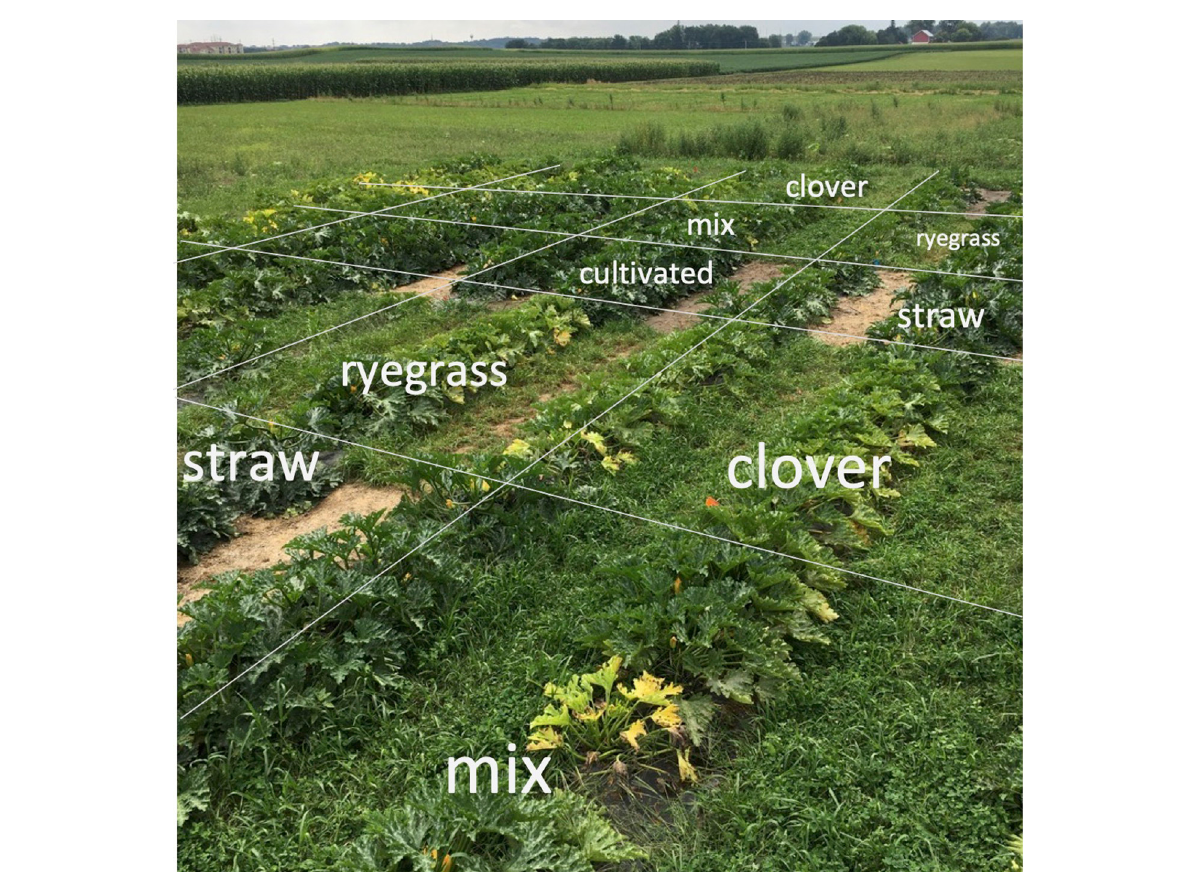
FIGURE8 Photograph of organic zucchini plants grown in living mulch treatments, 2019. Note that the particularly stunted and yellowed plant in the foreground mixed species living mulch plot was afflicted with fusarium wilt, whereas in many other living mulch plots the plants were yellowing without any particular disease identifiable as the